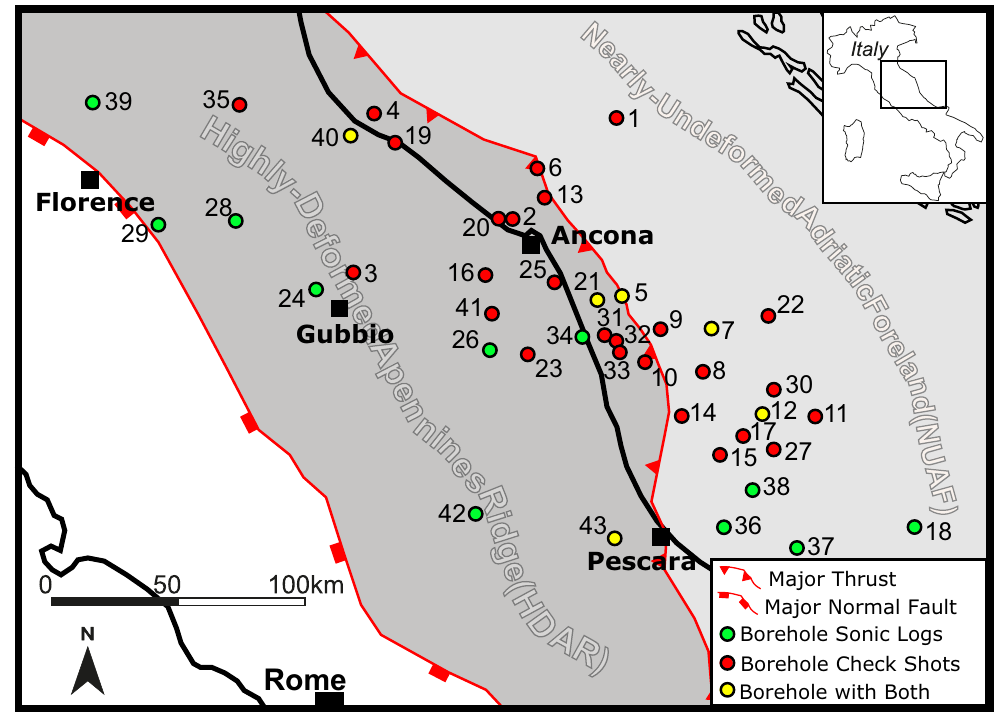
Figure 1. Schematic structural map where Highly Deformed Apennine Ridge (HDAR) and Nearly- Undeformed Adriatic Foreland (NUAF) are shown with the location map of the boreholes analyzed in this work. Green, Red and Yellow dots are for boreholes where, respectively, sonic logs, check shots or both were available. Numbers indicate the wells: 1 Alessandra1, 2 Barbarossa1, 3 Burano1, 4 Canopo1, 5 Conrad1, 6